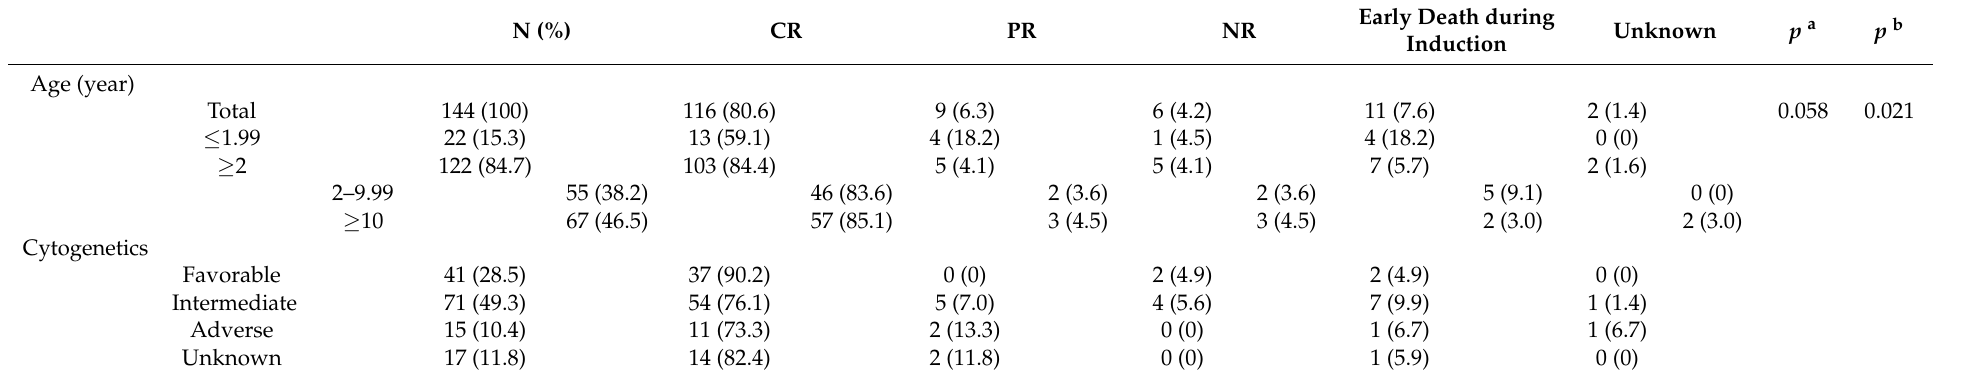
Table 2. Treatment response after induction chemotherapy by age and